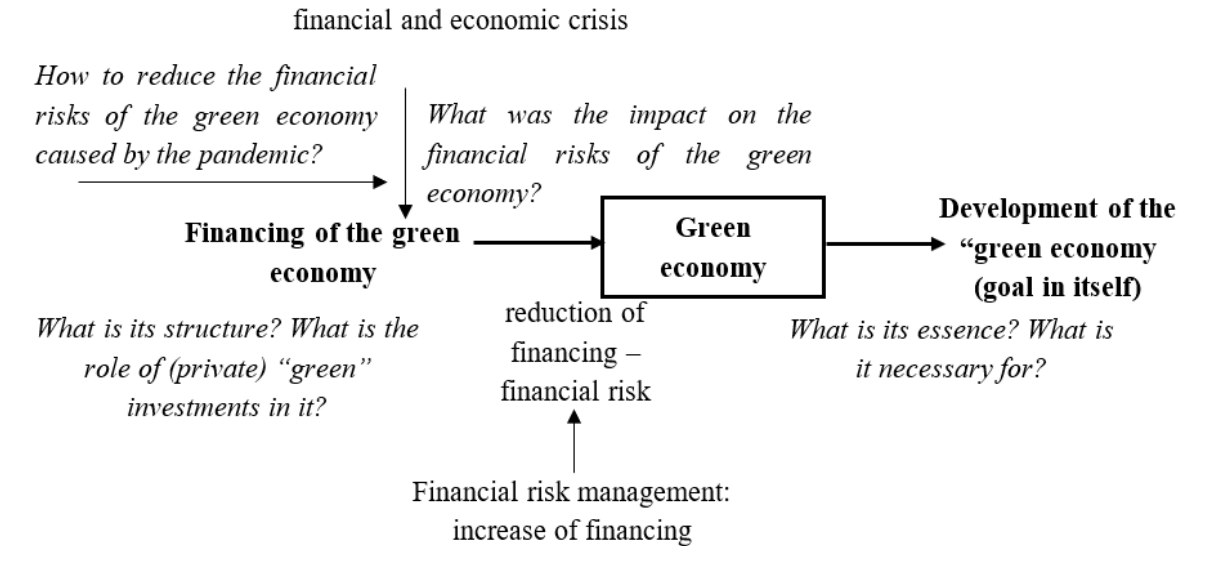
Figure 1. The fundamental provisions of the existing theory of financial risks of the green economy and the gaps in it. Source: authors.